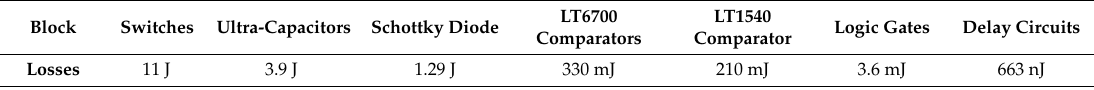
Table 1. Energy consumption of each respective block in the variable storage structure computed by LTspice simulation for a total supplied energy of 210 J and energy provided to the load of 192 J. LT6700 LT1540 Block Switches Ultra-Capacitors Schottky Diode Logic Gates Delay Circuits Comparators Comparator Losses 11 J 3.9 J 1.29 J 330 mJ 210 mJ 3.6 mJ 663